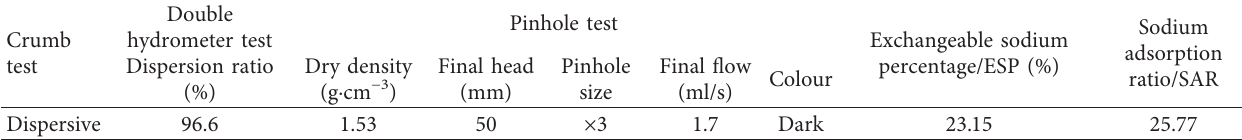
Table 3: Dispersibility of dispersive soil.